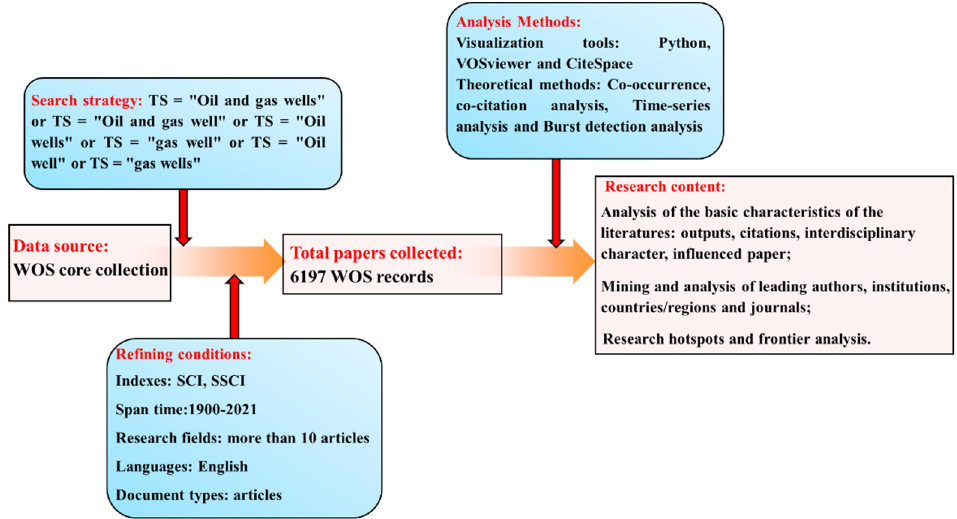
Figure 1. Data collection progress, analysis methods, and research content.